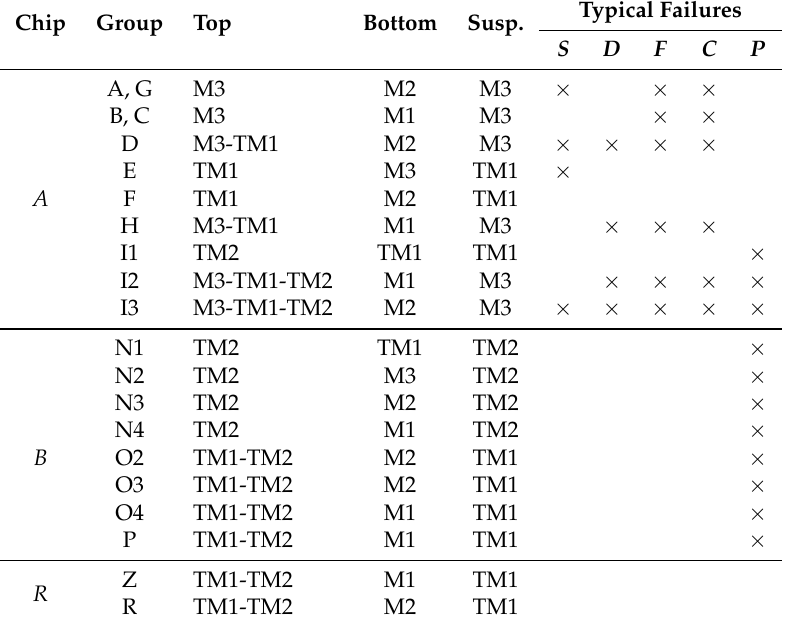
Table 1. Layer composition of z -axis devices on Accused , Bailed and Released chips. The typical failures are: device Stiction, Delamination, Fracture, Curling and Peeling of Ti/TiN or passivation.